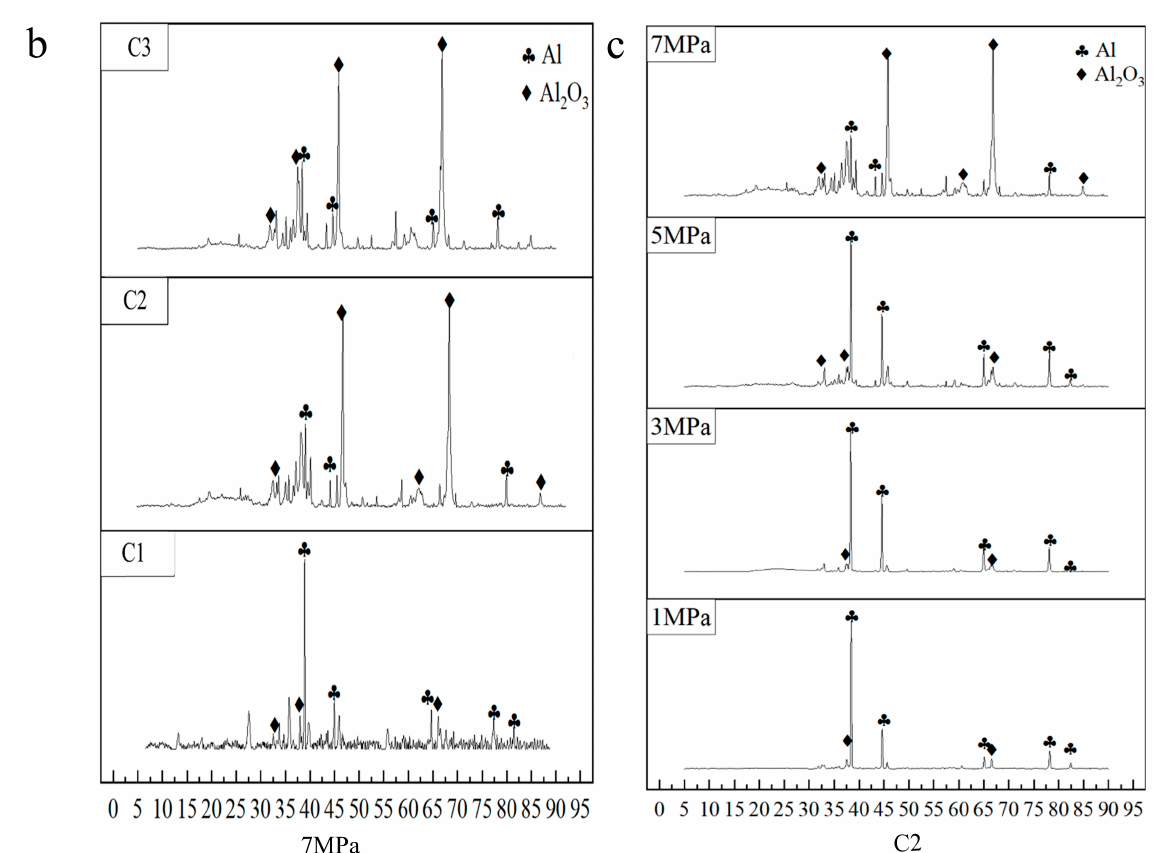
Figure 5. XRD pattern of CCPs: ( a ) CCP particle size distribution of three propellants at 7 MPa; ( b ) Comparison of the combustion efficiency of three propellants at 7 MPa; ( c ) XRD pattern of the C2 propellant.